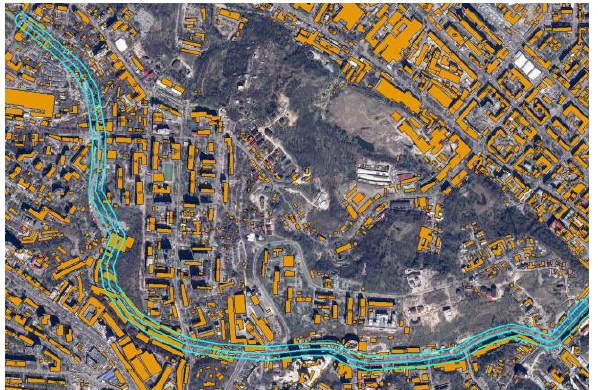
Figure 4. The channel and the coastal protective zone of the Hlybochytsya river (marked with blue), and the buildings within them (marked with